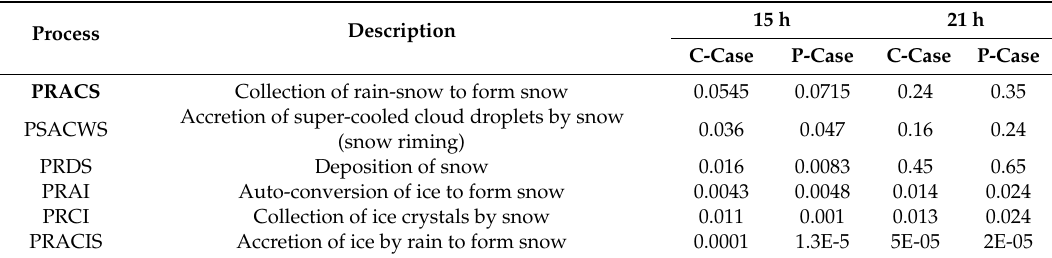
Table 3. Same as Table 1, but for